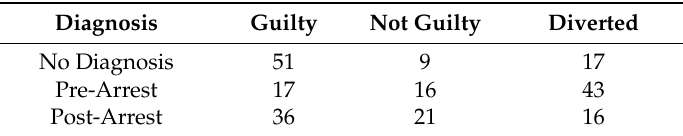
Table 1. Verdict by diagnosis condition.